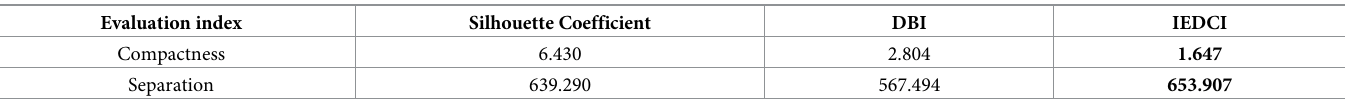
Table 9. Evaluation results of separation and